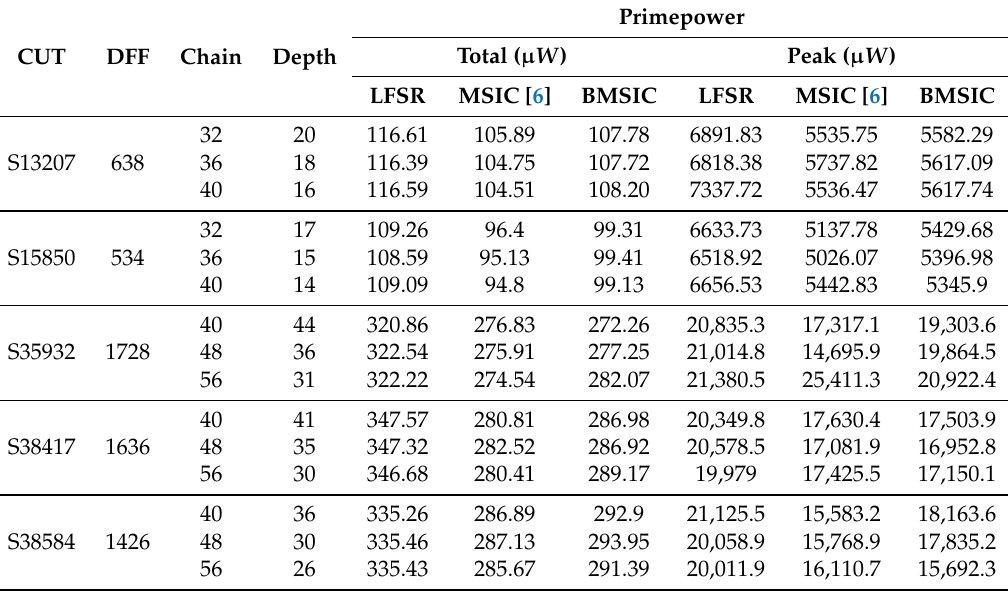
Table 3. Comparison of power simulation results of the three test generation methods.